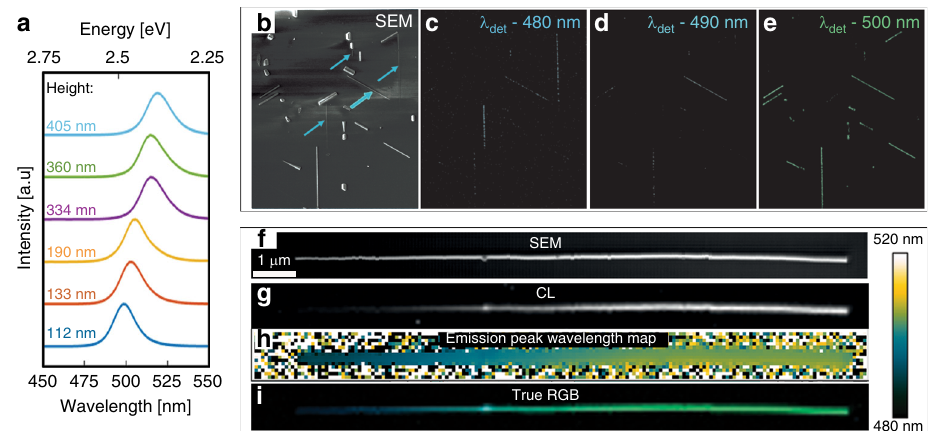
Fig. 2 Emission spectroscopy of surface-guided epitaxial CsPbBr 3 nanowires on C-plane sapphire. ( a ) PL spectra of nanowires with different heights (indicated in the fi gure) excited at 458 nm. SEM-CL monochromatic images of an ensemble of nanowires with varying heights: ( b ) SEM image and ( c – e ) CL monochromatic images generated by collecting the emitted light speci fi cally at 480, 490, and 500 nm, displaying the emission wavelength distribution of the nanowires. Spatially resolved CL spectroscopy on a single tapered nanowire: ( f ) SEM image, ( g ) CL map, ( h ) the extracted emission peak wavelength map with its color-scale to its right, and ( i ) a true RGB color map calculated from the fi tted emission peak displaying the varying emission wavelength, from green to blue, with the diminishing height of the tapered